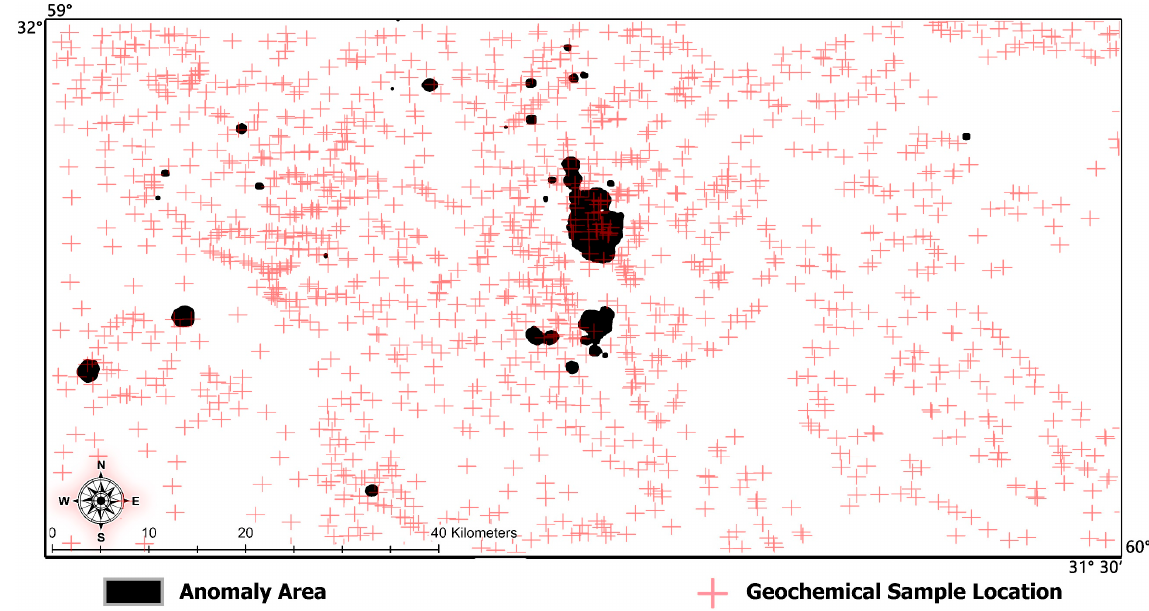
Figure 18. The map of the anomaly community.